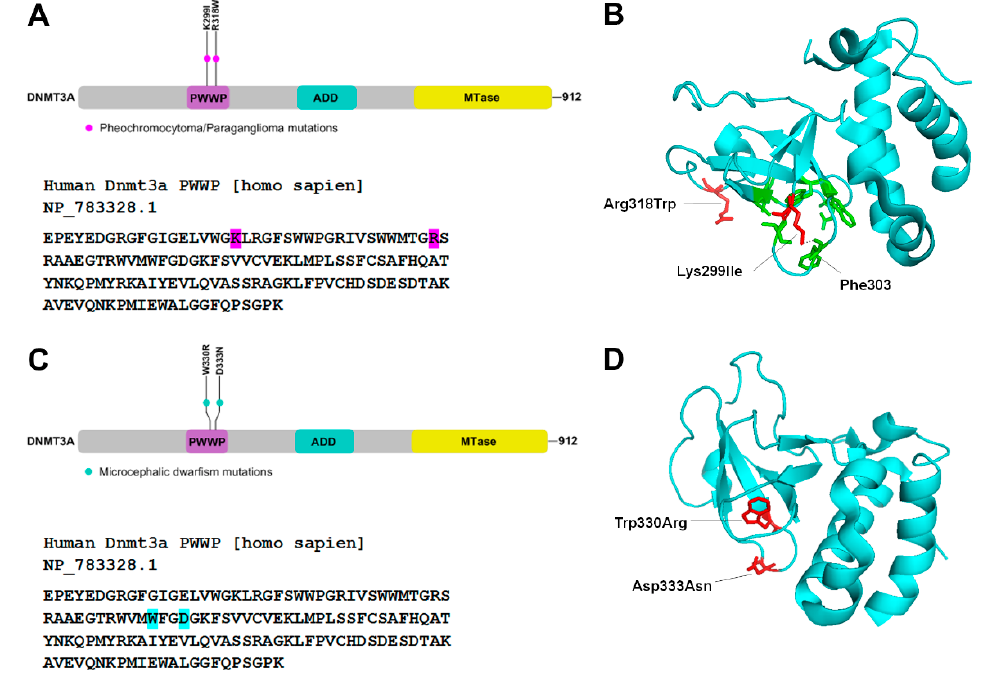
Figure 4. PCC/PGL (Pheochromocytoma/paraganglioma) and MD (microcephalic dwarfism) mutations in PWWP domain of DNMT3A ( A , C ) Top Schematic representation of the hDNMT3A gene, showing PCC/PGL and MD mutations in the PWWP domain. Below Nucleotide sequence of the PWWP domain, with the mutations highlighted in pink and blue respectively. ( B , D ) Crystal structure of DNMT3A PWWP domain shown in blue (PDB: 3LLR). The positions of PCC/PGL mutation ( B ) and MD mutations ( D ) shown as stick structures in red. The aromatic cage residues are shown in